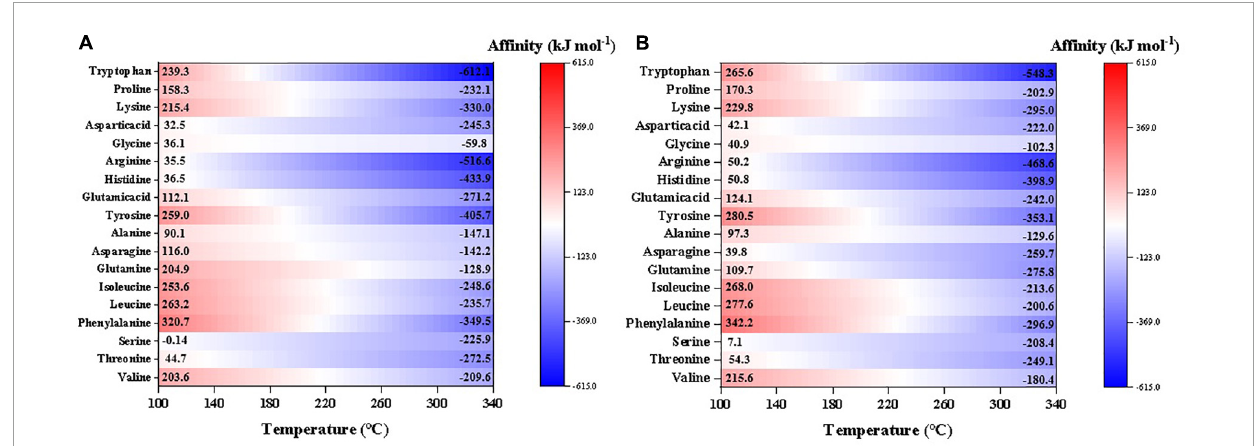
FIGURE6 Synthesis affinity of proteinogenic amino acids excluding S-containing species using (A) CO, g and (B) CO 2 , g as the carbon source. In the calculations, pH was set neutral, which is also temperature-dependent.